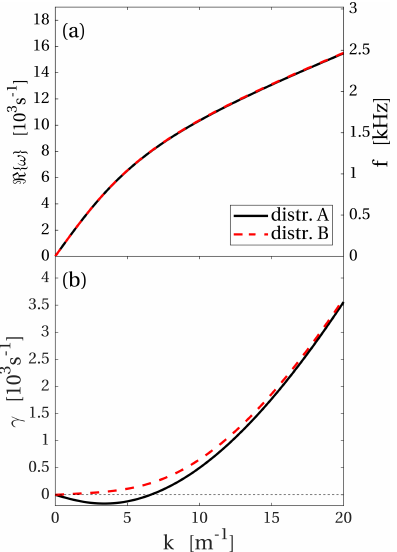
Figure 7. Dispersion relations while the spacecraft was outward- bound based on assumed distributions specified in Table 1. (a) Real part of the dispersion relation. (b) Damping rate γ . Positive val- ues of γ correspond to wave damping and negative values to wave